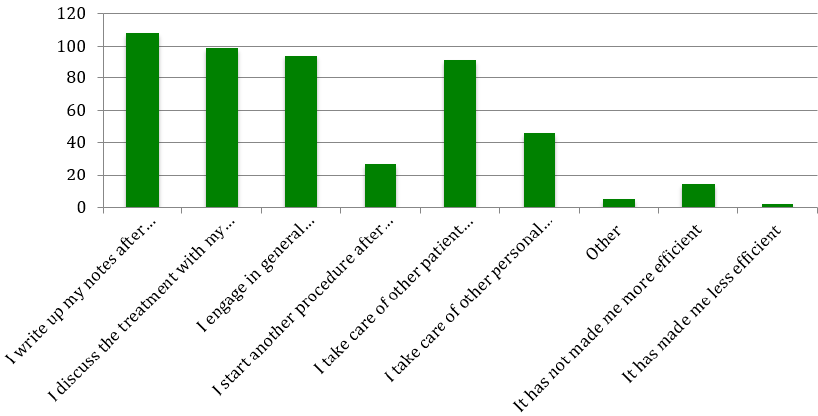
Figure 2. Most frequently reported ways that providers spend extra time gained from the implementation of the FRS (could choose more than one